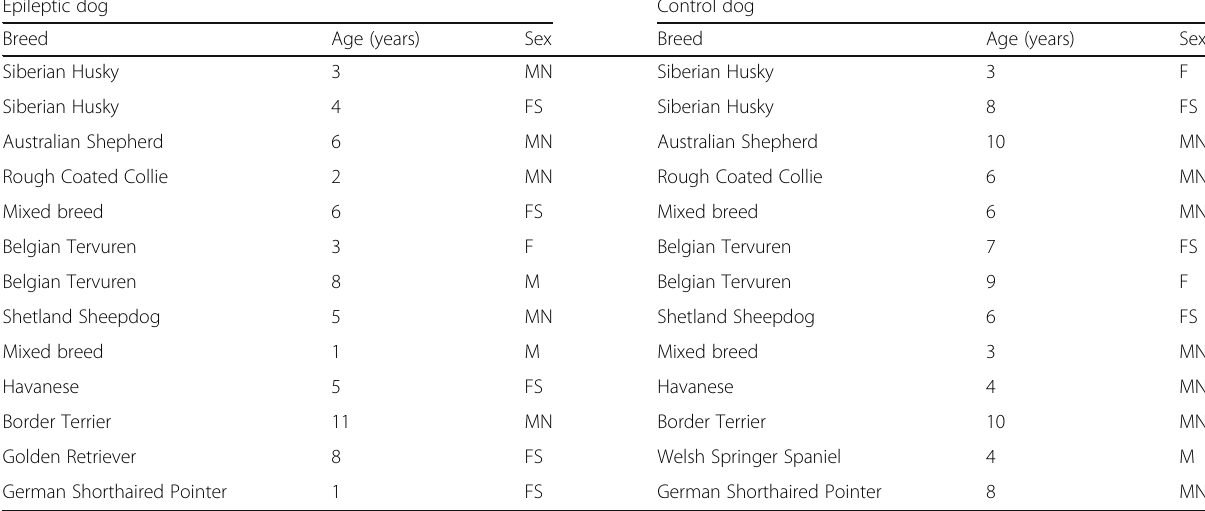
Table 1 Summary of demographic characteristics of paired epileptic and control dogs Epileptic dog